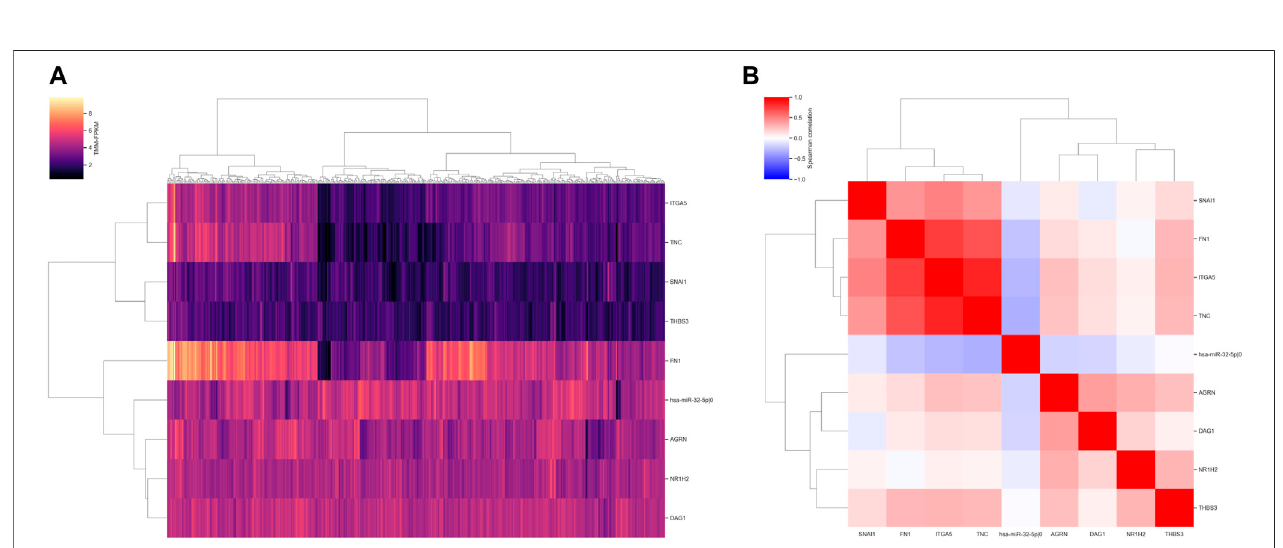
FIGURE 5 | Expression distribution of the nine prognostic molecules. (A) Normalized and log 2 -transformed expression units. (B) Spearman correlation matrix.